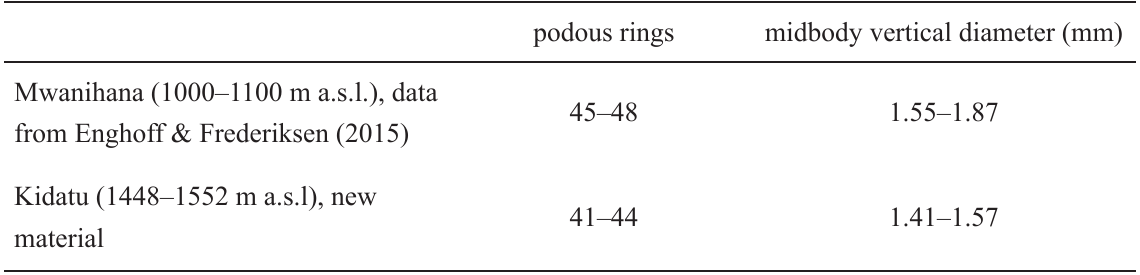
Table 1. Comparison of Aquattuor submajor Enghoff, 2015 (males) from Mwanihana and